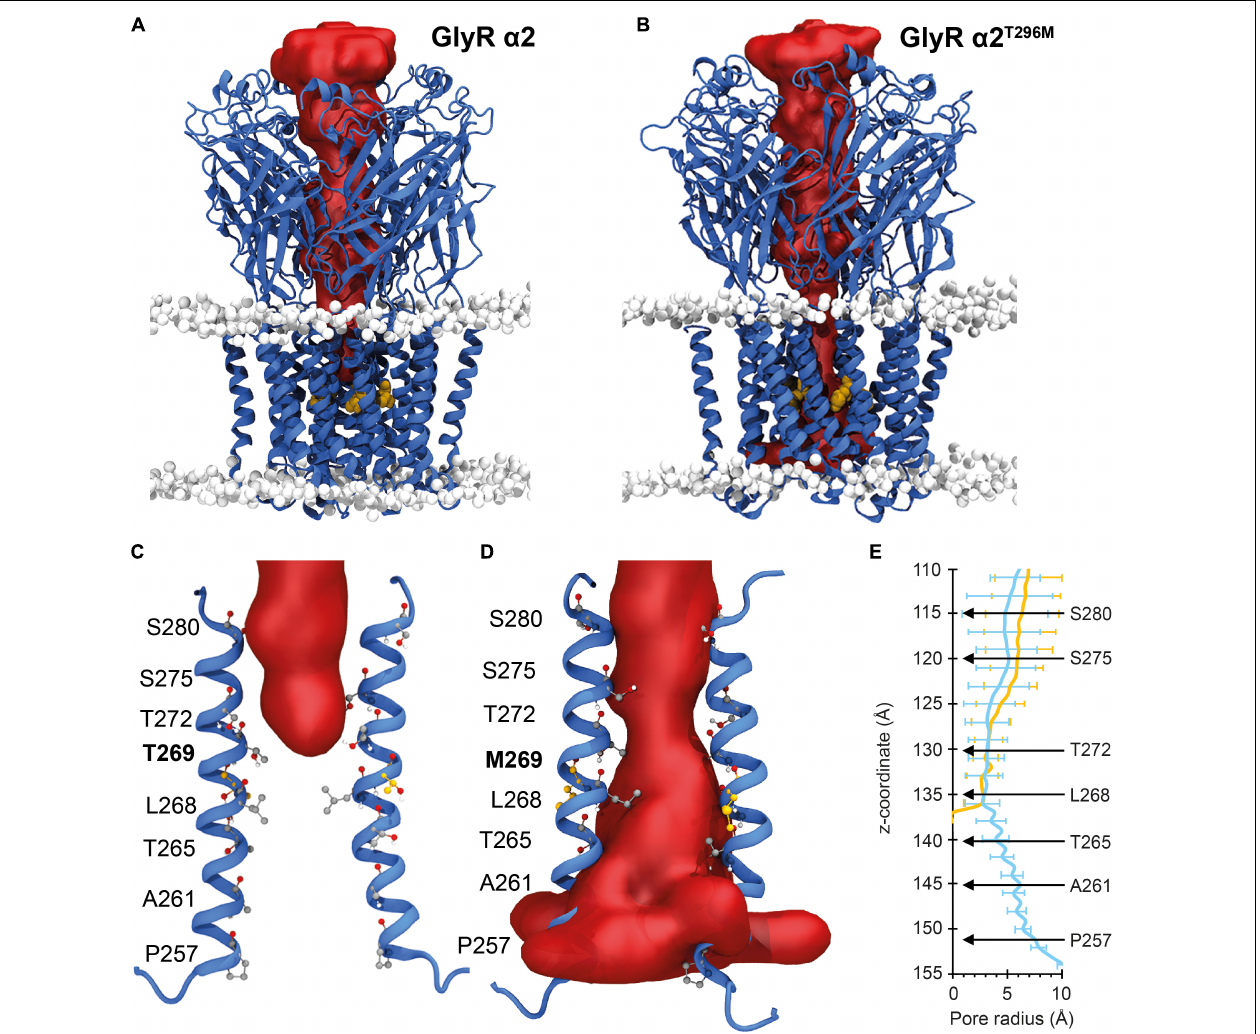
FIGURE 3 | Molecular dynamic simulations of wild-type GlyR α 2 and GlyR α 2 T269M variants. Mean internal cavity surface detected for GlyR α 2 homomers in a model membrane (headgroups shown in gray) for: (A) wild-type GlyR α 2 T269 and (B) the GlyR α 2 T269M variant over the 1.5 µ s of combined production simulation. The site of the M269 mutation is shown in gold. The channel radius (Å) of the wild-type GlyR α 2 is compared to the GlyR α 2 T269M variant over the 1.5 µ s of combined production simulation. (C,D) The red surfaces show the solvent volume within wild-type GlyR α 2 T269 and GlyR α 2 T269M channels. Wild-type GlyR is occluded to water at the level of T272, while water permeates the length of the GlyR α 2 T269M variant. (E) The radius of the channel (Å) along the transmembrane region of the longitudinal channel axis is given in the right panel. Selected residues along the channel have been noted for reference and to enable calibration of the distance along the z -axis (in Angstroms) with a residue number. blue indicates GlyR α 2 T269 , yellow indicates GlyR α 2 T269M .